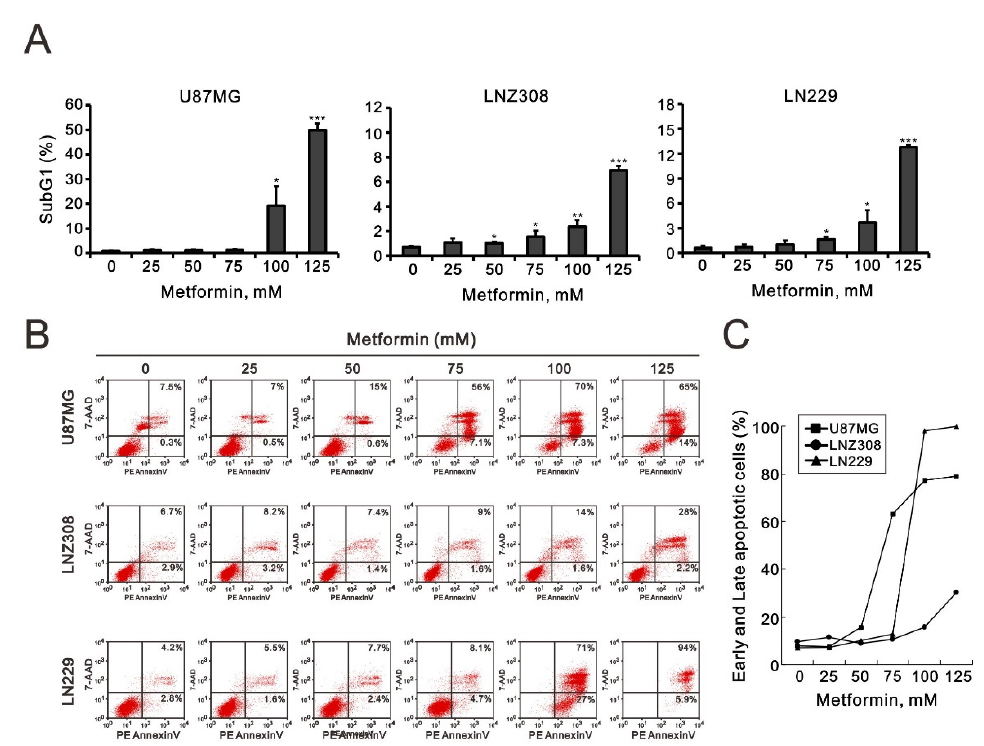
Figure 2. The effects of metformin on the cell-cycle profile and cellular apoptosis in GBM cell lines. ( A ) U87MG, LNZ308, and LN229 cells were treated with the indicated metformin concentrations for 24 h. The population of cells in the sub-G1 phase of the cell cycle was measured using flow cytometry analysis and statistically plotted. * p < 0.05, ** p < 0.01, and *** p < 0.001. ( B ) U87MG, LNZ308, and LN229 cells were treated with the indicated metformin concentrations for 24 h. Cells were stained with PE–annexin V and 7-AAD and were measured using flow cytometry analysis. Their quantification of early and late apoptotic cells showed as ( C